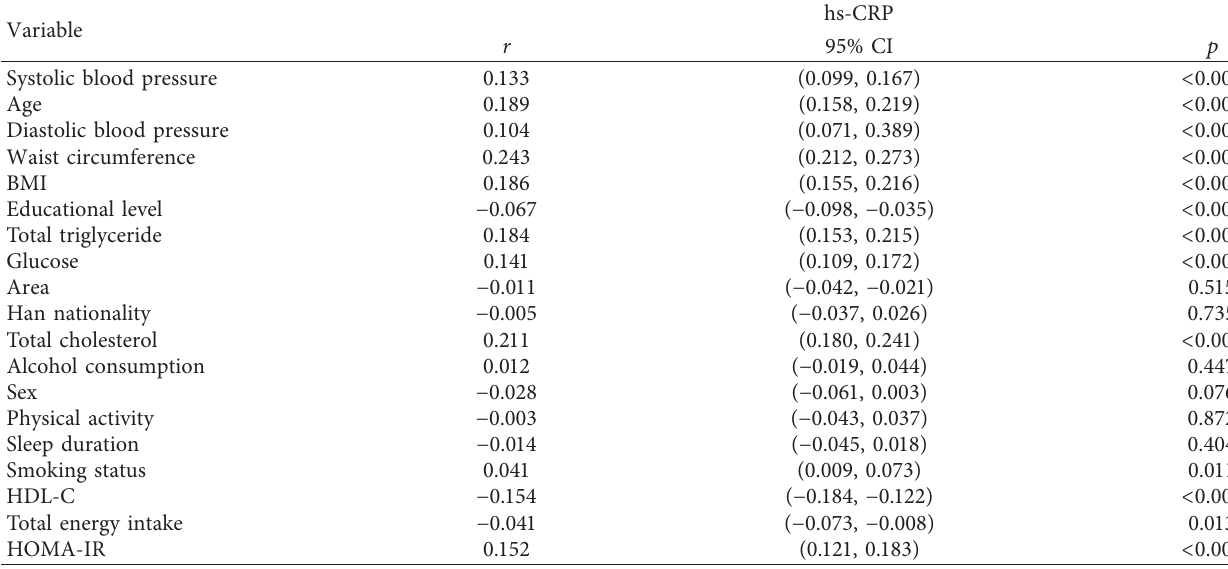
Table 2: Correlation of hs-CRP with relevant covariates in the 2009